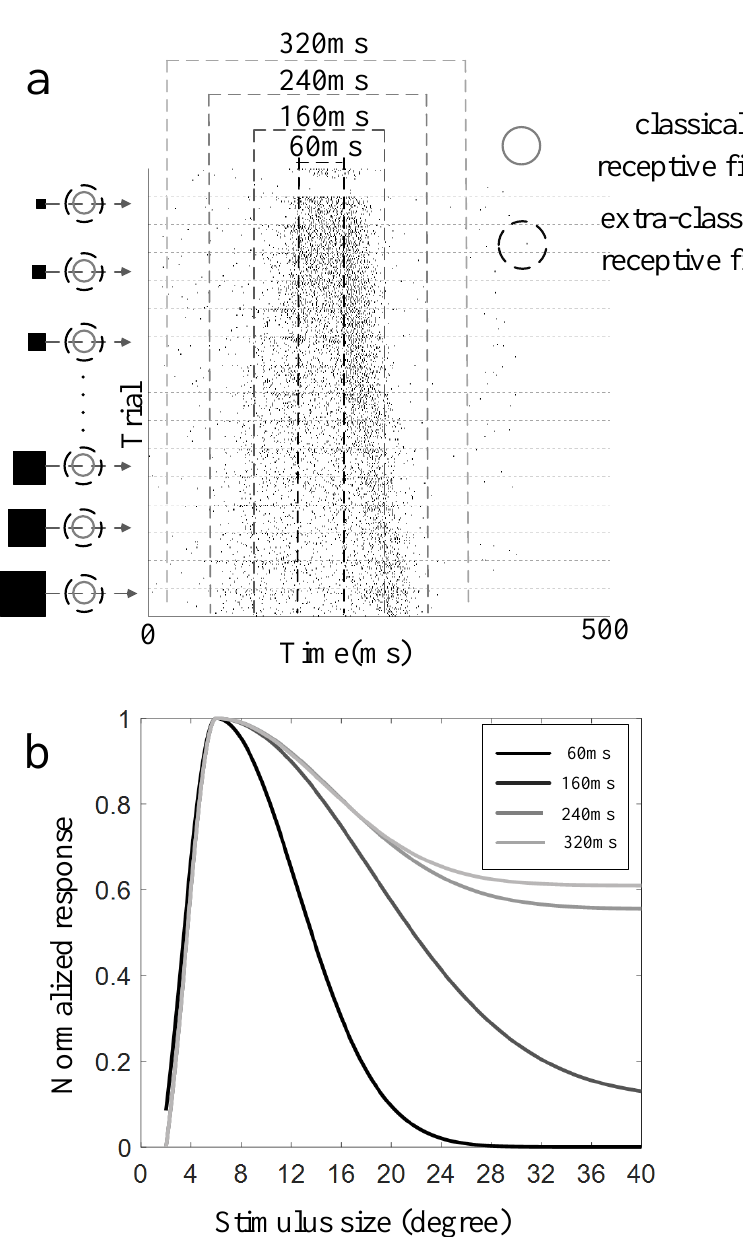
same as in Figure 4a. The black square in each subfigure denotes varying lengths of flashed bars. ( b , c ) The mean firing rates of 20 repeats at an example recording site under each stimulus shown in ( a ); the horizontal line indicates the median of each group of data and the whiskers indicate the lowest and highest point within 1.5 × of the interquartile ranges of the lower or upper quartile, respectively. Each black asterisk represents firing rates of a single trial. ( d ) The normalized fitted size-tuning curves under each stimulus shown in ( a ) (red: adjust-R 2 = 0.9049, ascending limb; adjust-R 2 = 0.8737, descending limb; blue: adjust-R 2 = 0.9796, ascending limb; adjust-R 2 = 0.8354, descending limb) as well as in Figure 2a (black: adjust-R 2 = 0.9462, ascending limb; adjust-R 2 = 0.8628, descending limb); ( e ) the suppression index for flashed square stimulus versus two groups of the flashed bars. Each dot represents SI from a single recording site. Red symbols show SIs of R c by R bar, and blue of R e by R bar. The diagonal line displays the locus of equal value.